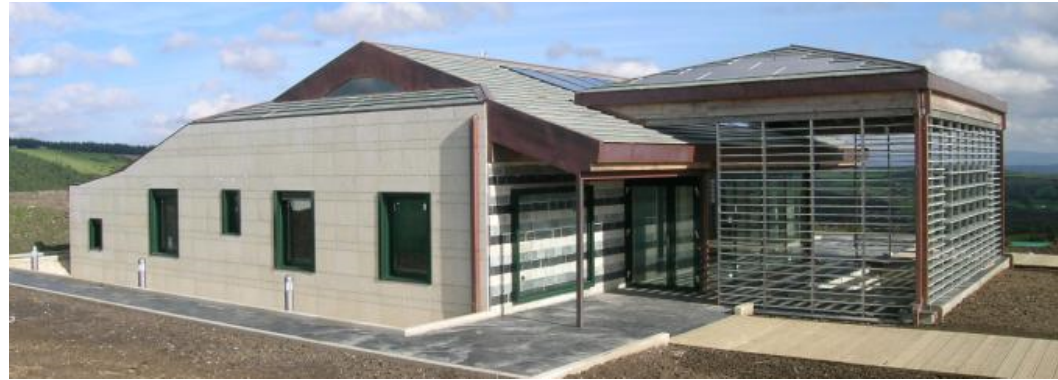
Figure 1. Sotavento bioclimatic